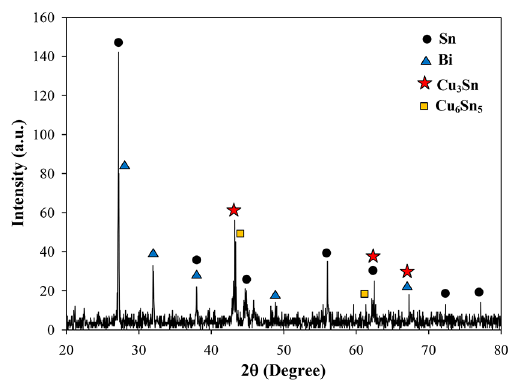
Figure 3. X-ray diffraction patterns obtained from the Sn-36Bi-22Cu alloy